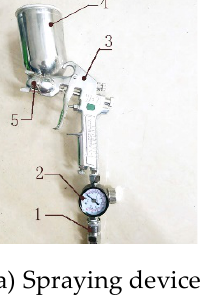
Figure 1. The spraying device: 1-Air inlet; 2-barometer; 3-Sprayer; 4-The pot of sprayer; 5-Nozzle; 6-Material container.